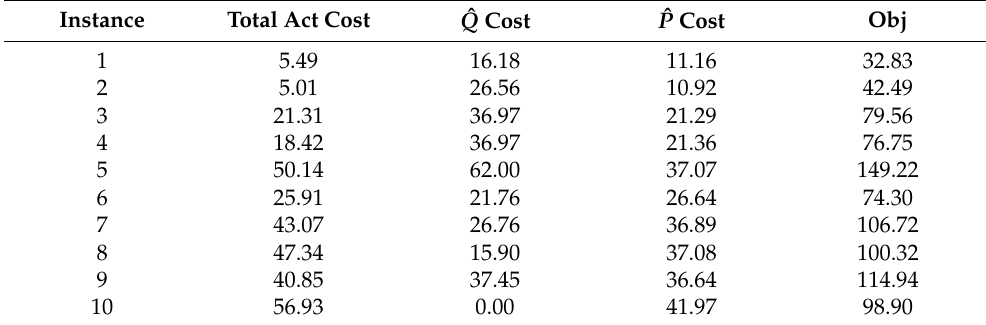
Table 4. Results of the first instance of each type considered in Table 2 without the cost component ( a ) of the objective